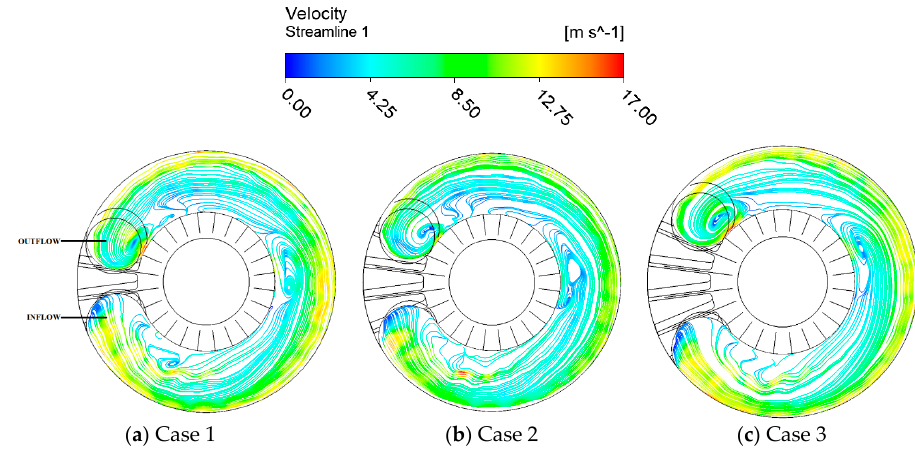
Figure 10. Velocity streamline plots.